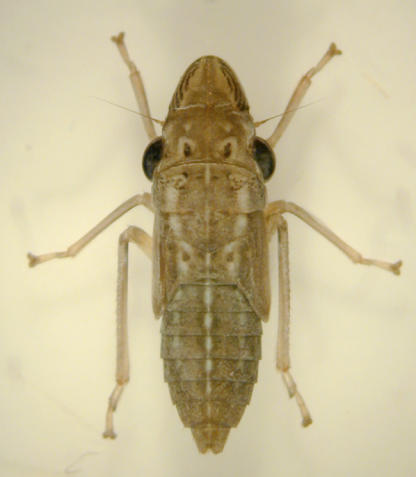
The genomes of two bacterial species that supply essential nutrients for the glassywinged sharpshooter provide potential targets for controlling infestations of this greatly feared agricultural pest